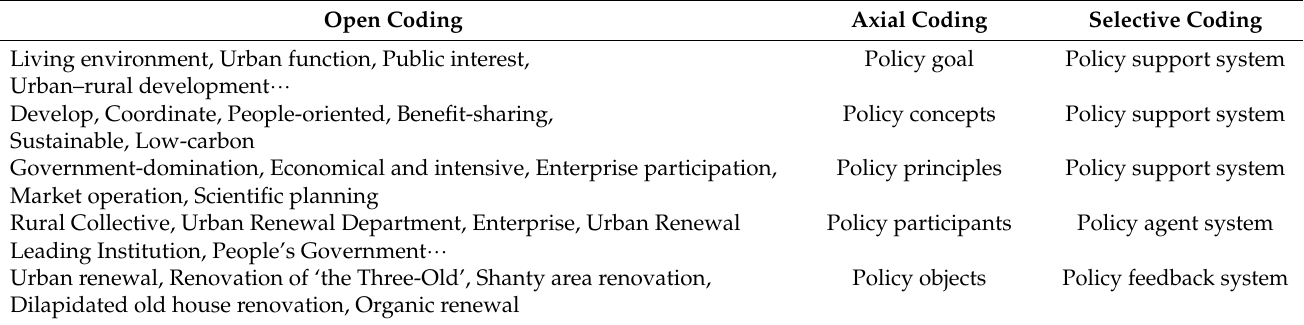
Table 6. Axial coding and selective coding table